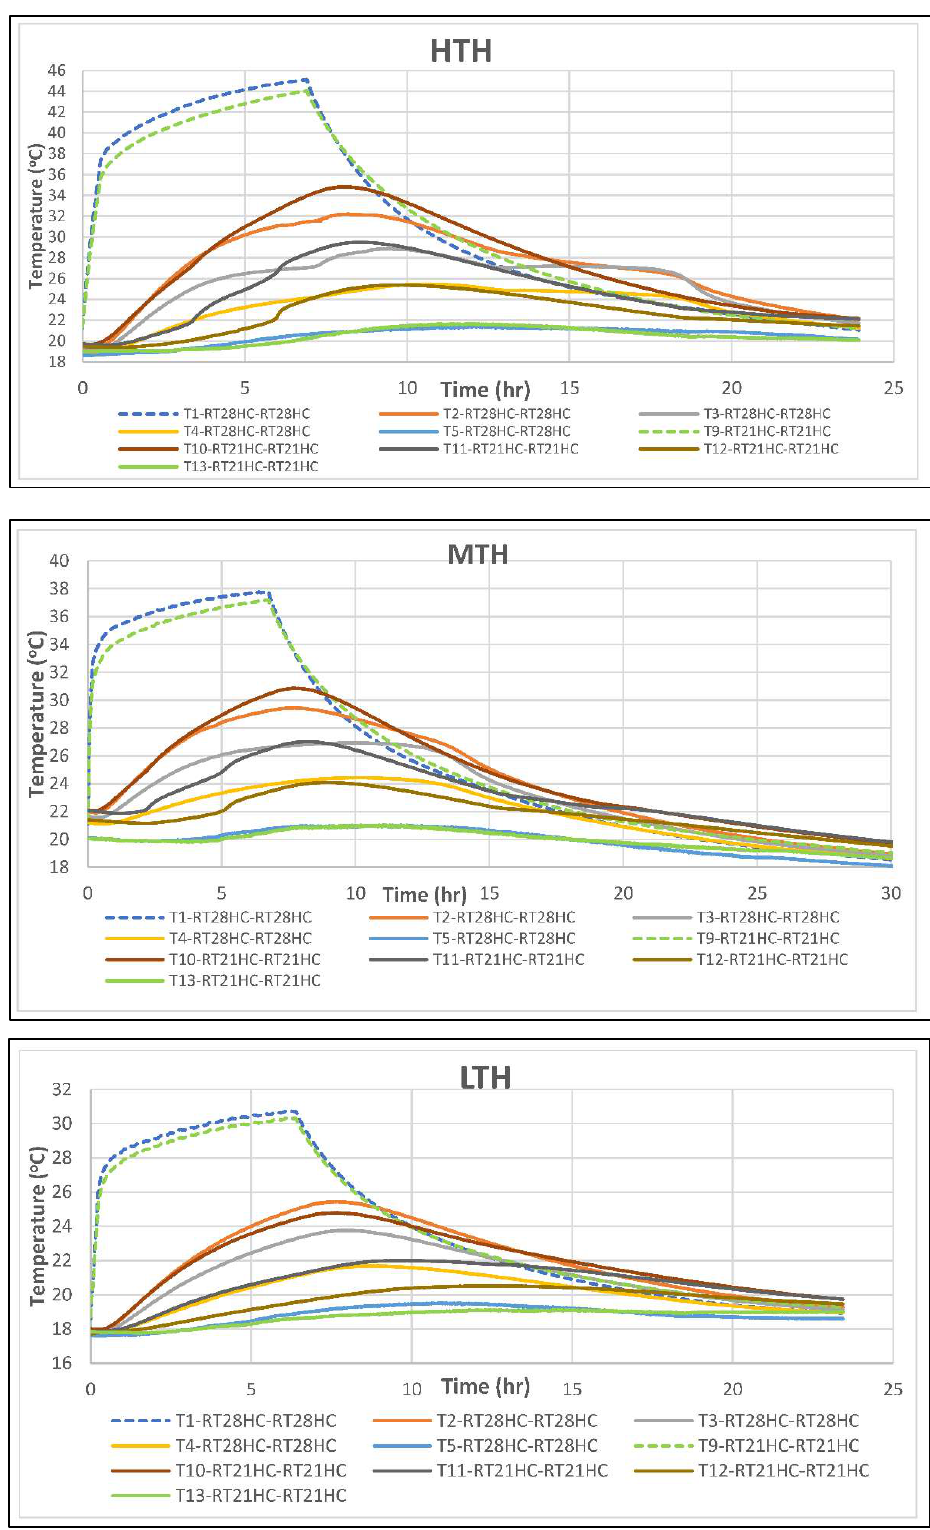
Figure 9. Temperature distribution for concrete samples integrated with PCMs RT28HC–RT28HC and